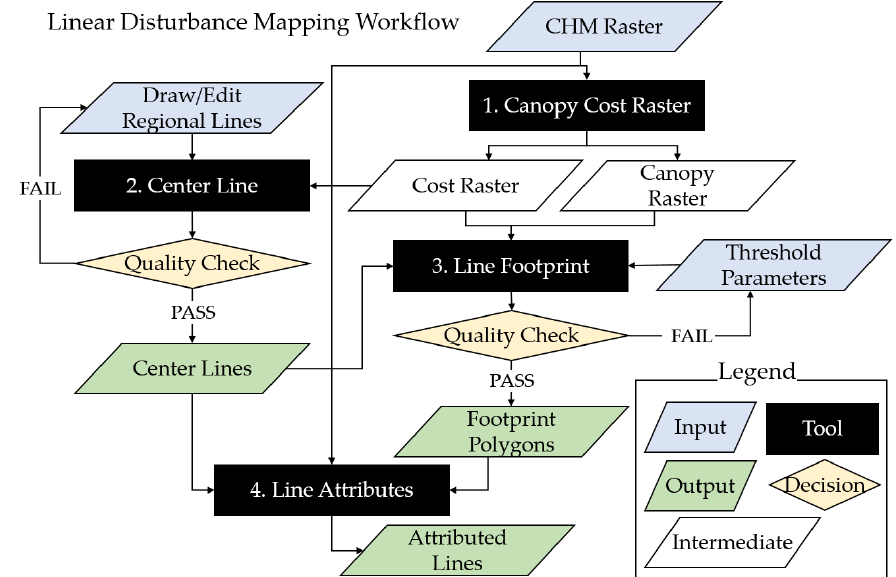
Figure 2. Flowchart of the semi-automated linear disturbance mapping workflow. The only inputs required from the user are a canopy height model (CHM) Raster, seed points, and threshold parameters. The latter two may require refinements in case outputs do not pass quality checks. Tools are fully automated python scripts listed in sequential order of which they are normally used. Tool numbers coincide with the 2.2 subsection numbers in which tool algorithms are explained. Optional parameters are available in each tool and not displayed in this graph.